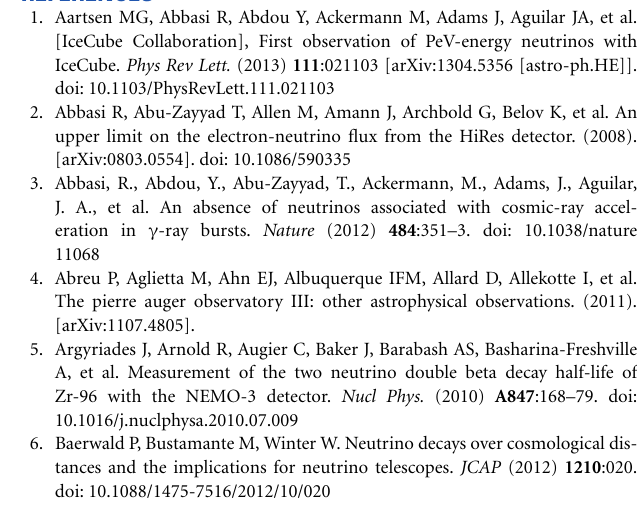
FIGURE 3 | Left panel: single majoron-emitting J 0 νββ coupling (cid:9) g ee (cid:10) vs. (cid:9) g 12 (cid:10) , when varying the values of the neutrino mass terms, for the best fit values of the neutrino mixing angles and δ = 0.